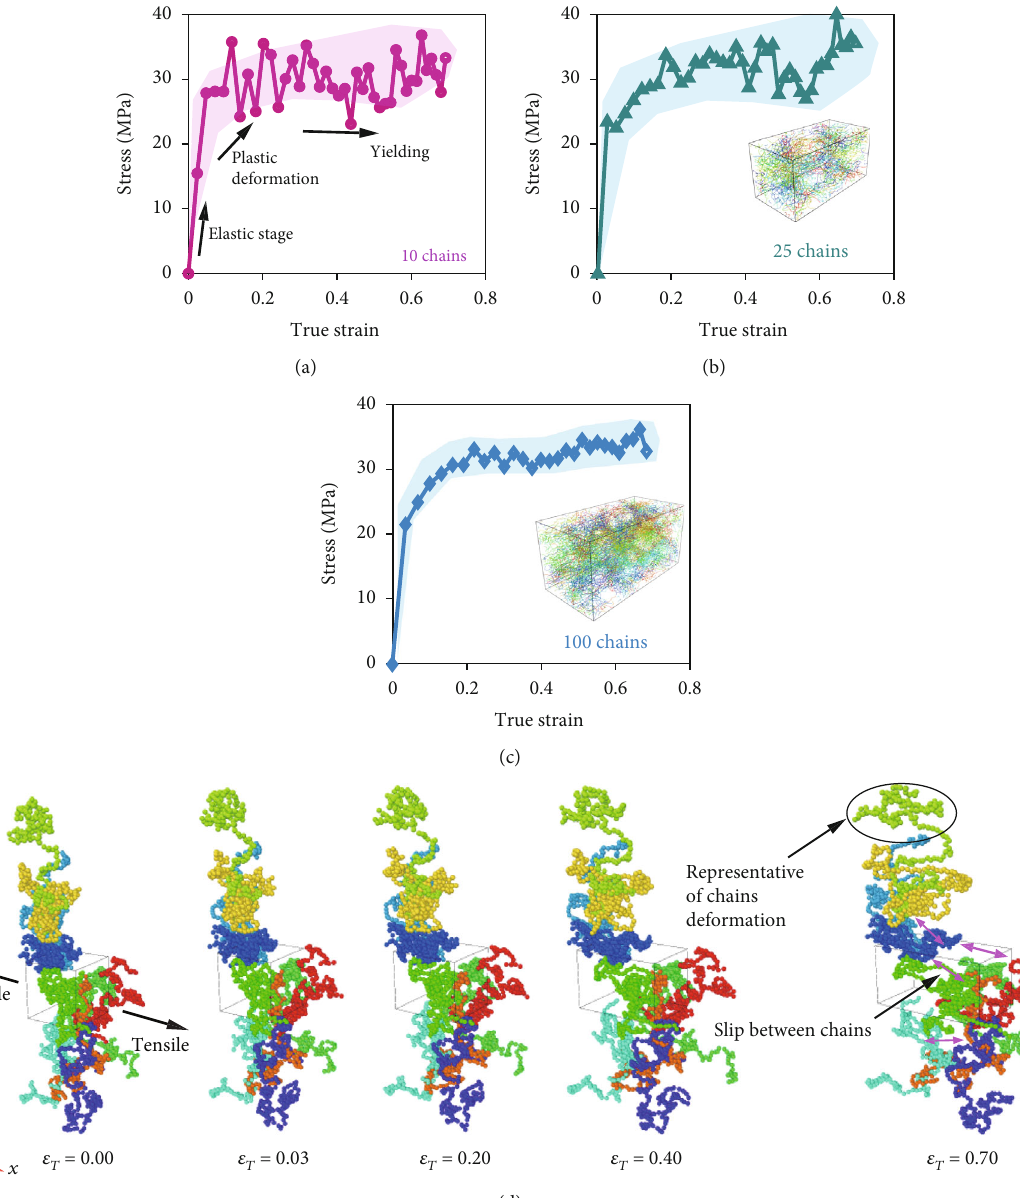
Figure 4: (a – c) Stress-strain curves of coarse-grained PU models with di ff erent numbers of chains under tensile at a strain rate of 5 × 10 10 /s and (d) the evolution of molecular con fi guration containing 10 PU chains at di ff erent